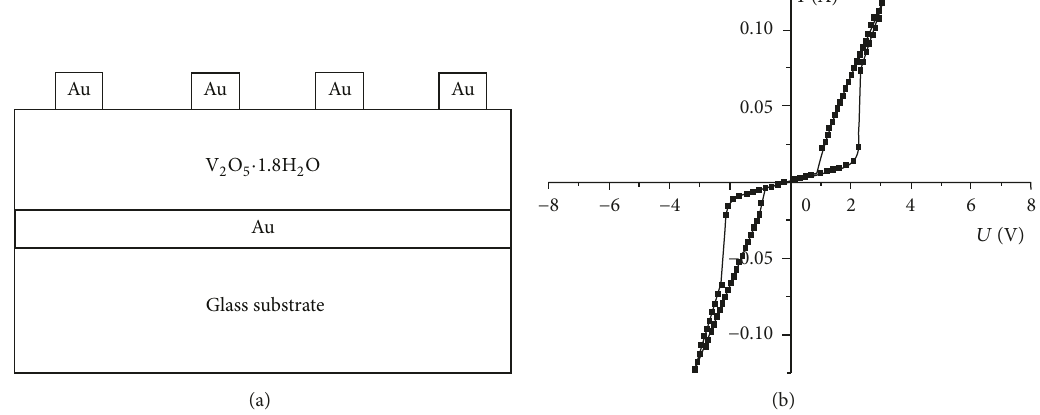
Figure 13: (a) Schematic sandwich structure: diameter of Au top electrodes is 0.9 mm. (b) I-V curve after EF.